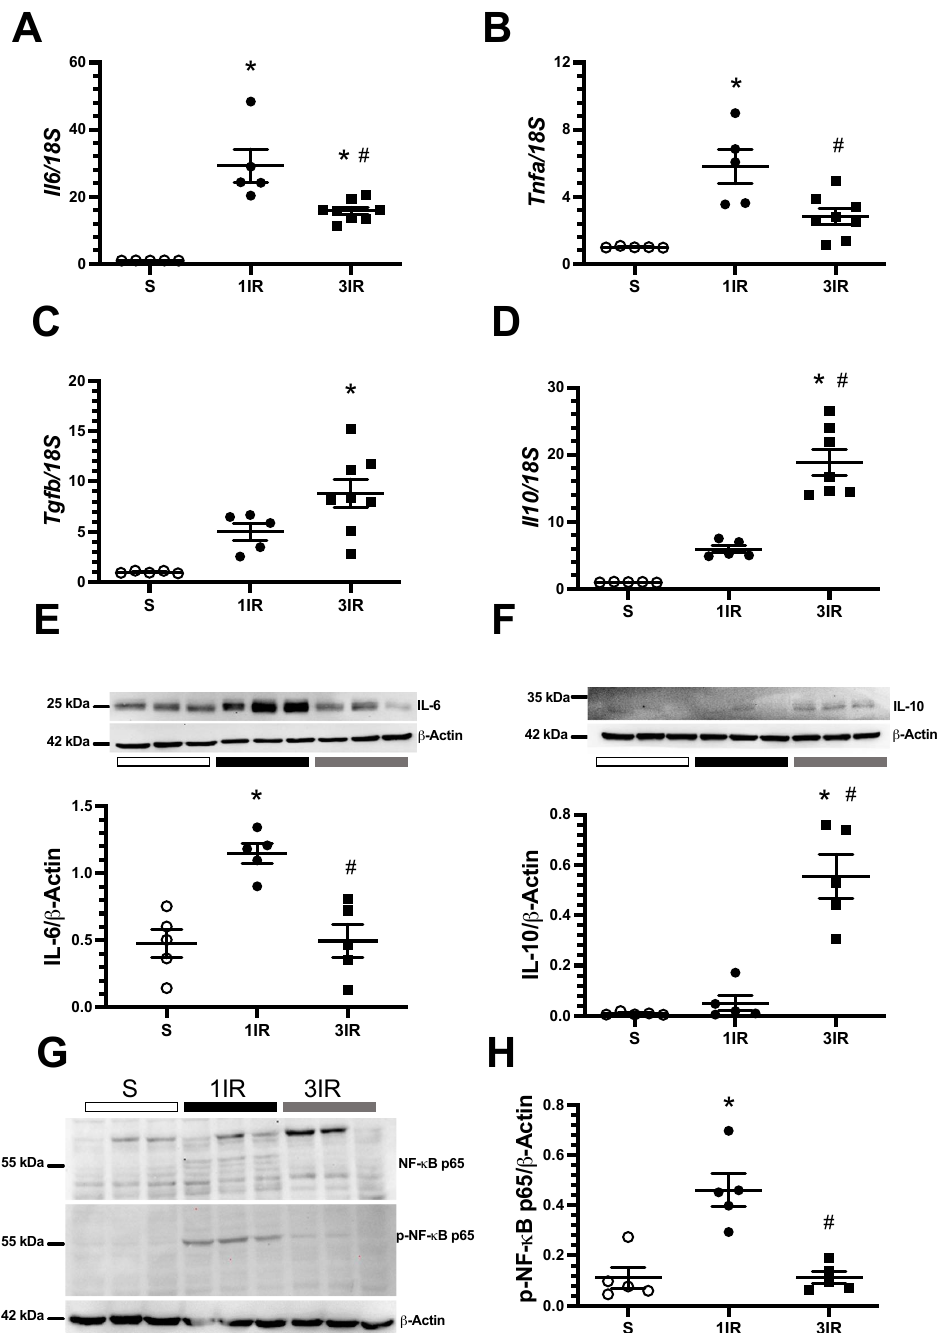
Figure 5. Three consecutive episodes of IR induced lesser renal inflammation than the 1IR group. ( A ) IL-6, ( B ) TNF- α , ( C ) TGF- β and ( D ) IL-10 mRNA levels. In ( E ) appears IL-6 protein and in ( F ) IL-10 protein expression, ( G ) representative images of Western blot analysis for NF- κ B p65, p-NF- κ B p65 (s536) and β -actin, and in ( H ) appears the ratio between p-NF- κ B p65 and NF- κ B p65. All these assessments were performed 24 h after the last IR episode. The sham group is represented in white circles, the 1IR group in black circles, and the 3IR group in black squares. * p < 0.05 vs. S; # p < 0.05 vs. 1IR